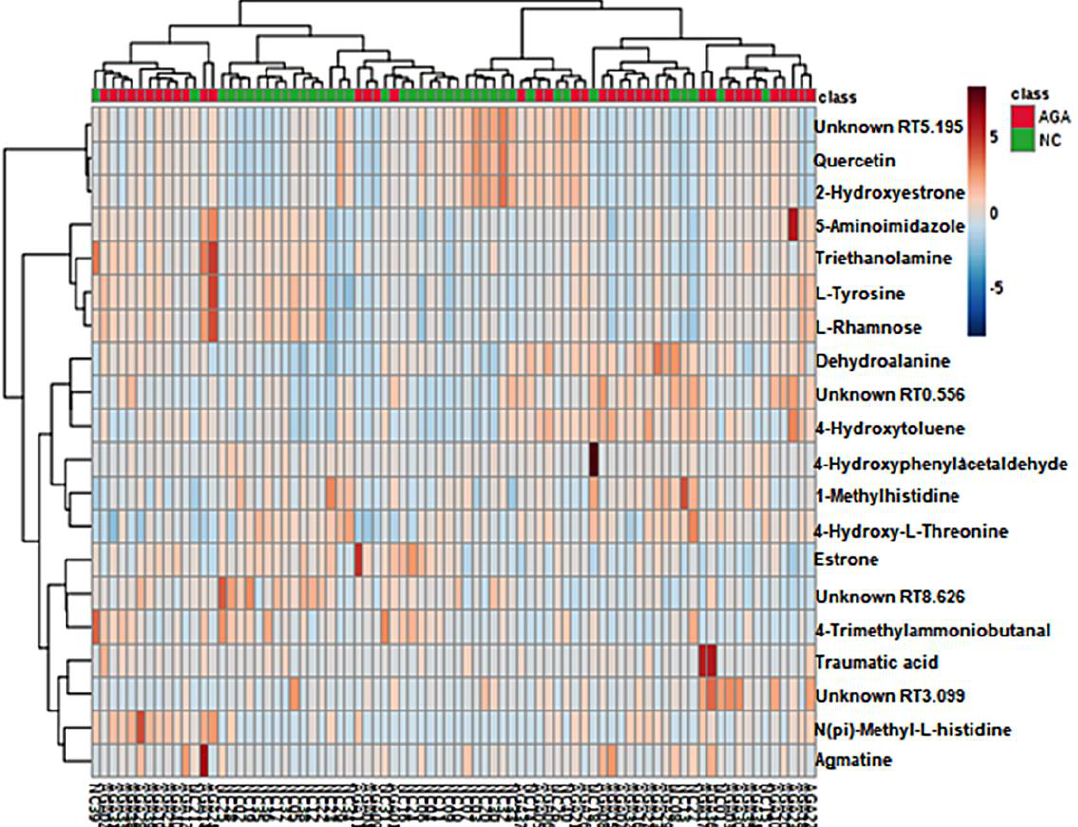
Figure 2. Heatmap of the 20 differentially accumulated metabolites. The heatmap shows a visualization of the changes in abundance/level of features in rows. The color ranged from deep red, indicating high abundance, to deep blue, indicating low abundance. On the top of the heatmap, green bars indicate normal controls, and red bars indicate the patients with male pattern baldness (MPB) who have been treated with finasteride for a year.